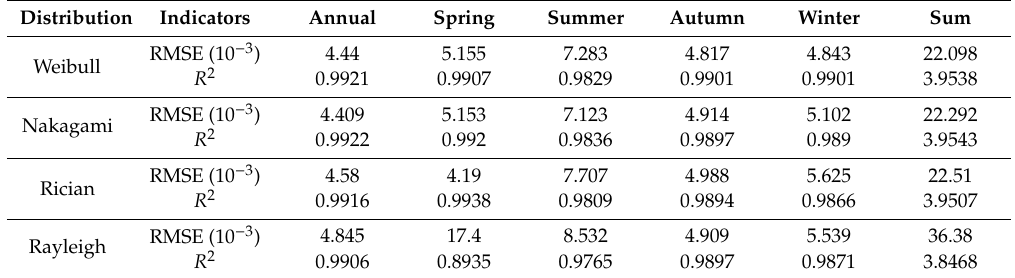
Table 8. Error evaluation of PDFs in the whole year and each season.